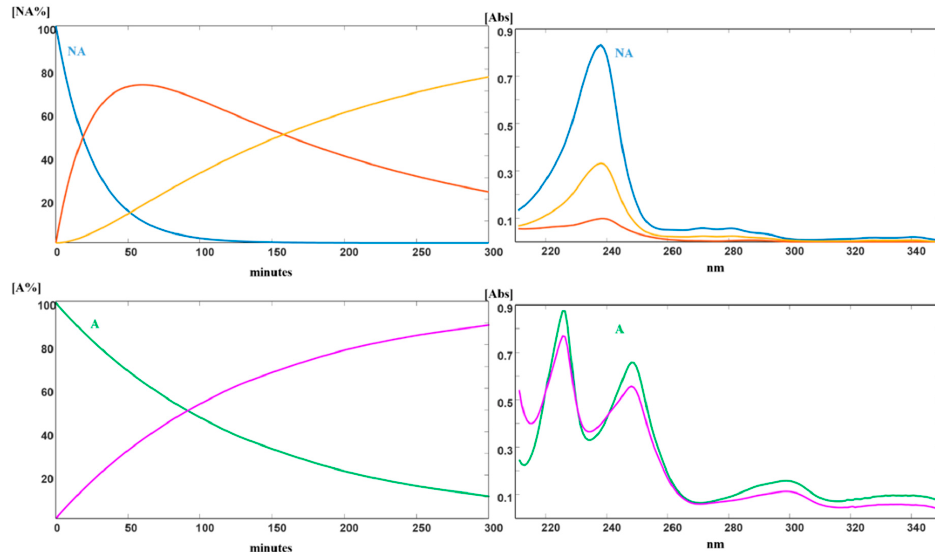
Figure 3. Photodegradation of NA and A: kinetic profiles and absorbance spectra of the pure compounds and respective photodegradation products.